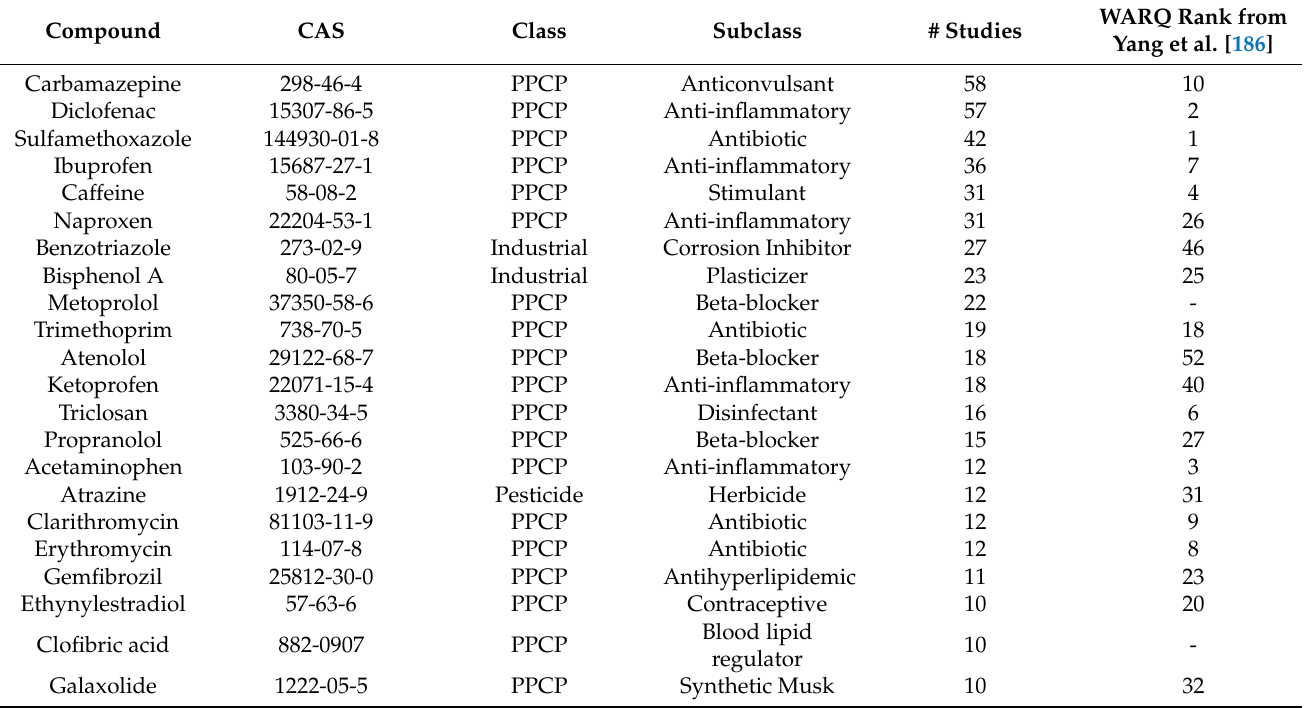
Table 2. Most studied emerging contaminants in primary research from literature